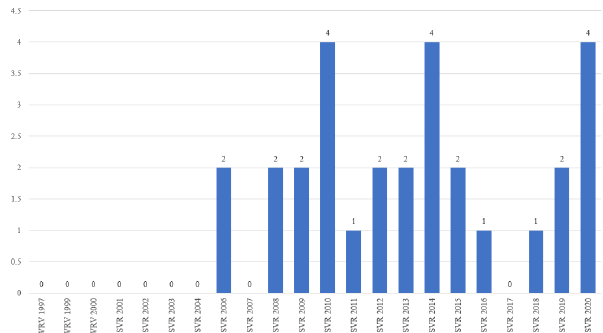
Figure 13. Overall distribution of papers from the “Tracking/sensing”